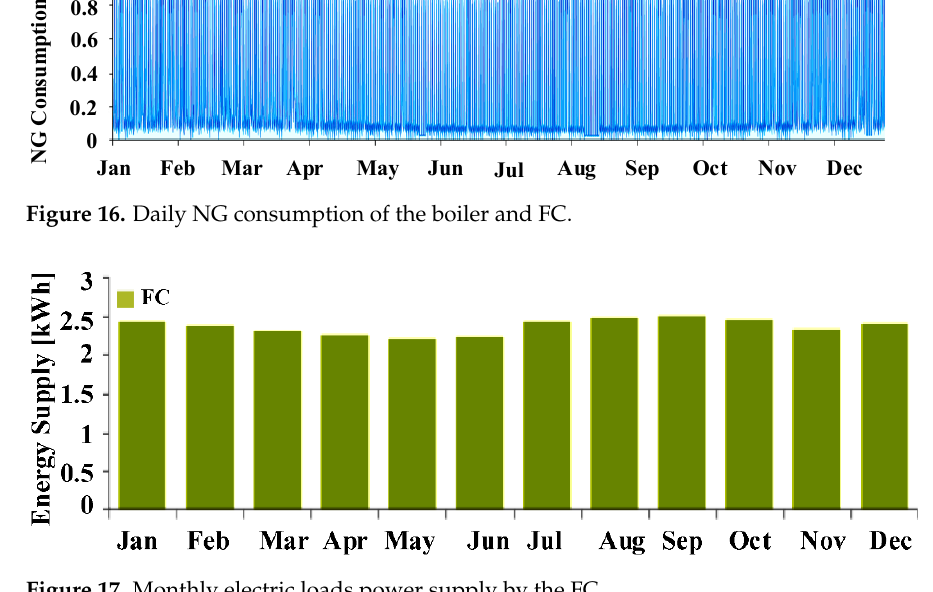
Figure 17. Monthly electric loads power supply by the FC.